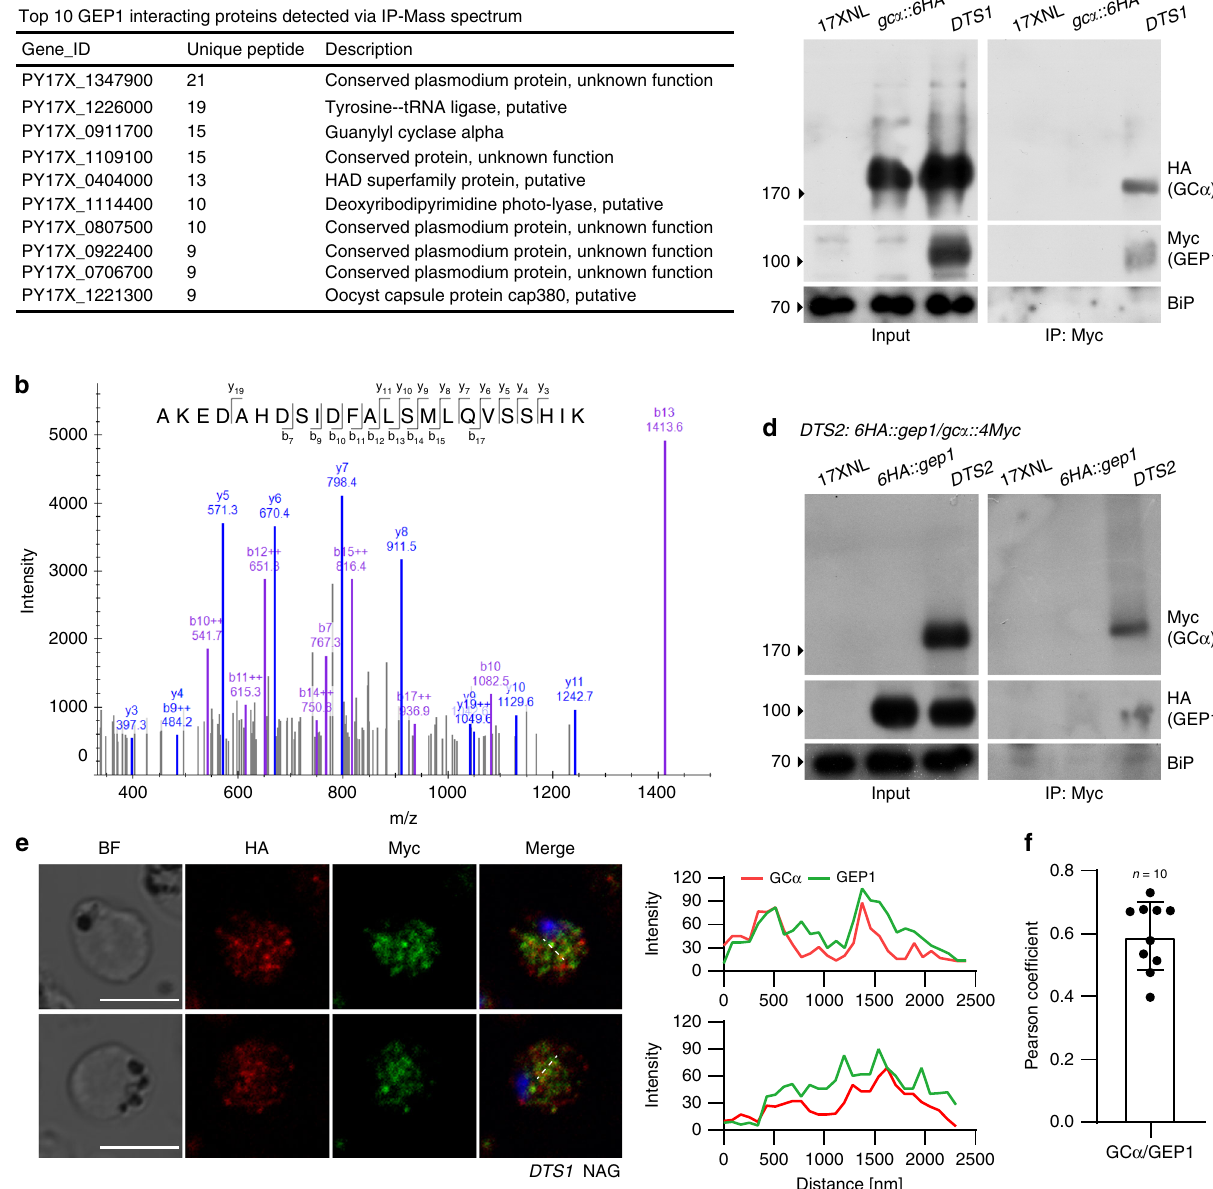
Fig. 5 GEP1 interacts with GC α in gametocytes. a Top 10 GEP1 interacting proteins in the gametocytes of the 6HA::gep1 parasite detected by immunoprecipitation and mass spectrometry (MS), including guanylyl cyclase α (GC α ) with 15 peptides detected. b MS2 spectrum of a representative peptide of the GC α protein. c Co-immunoprecipitation of Myc::GEP1 and GC α ::HA proteins in gametocytes of the double tagged parasite 4Myc::gep1/ gc α ::6HA ( DTS1 ). IP-Myc, anti-Myc antibody was used. d Co-immunoprecipitation of HA::GEP1 and GC α ::Myc proteins in gametocytes of the double tagged parasite 6HA::gep1/gc α :: 4Myc ( DTS2 ). IP-Myc, anti-Myc antibody was used. e Two-colored IFA of GEP1 and GC α proteins in the DTS1 gametocytes using anti-HA (GC α ) and anti-Myc (GEP1) antibodies (left panel). Cross sections (white dash line) of the cells show the co-localization of GEP1 and GC α (right panel). Scale bar = 5 μ m. f Pearson coef fi cient analysis for GEP1 and GC α co-localization shown in e , data are shown as mean ± SD from n = 10 cells measured. Experiments in c , d , and e were repeated three times independently with similar